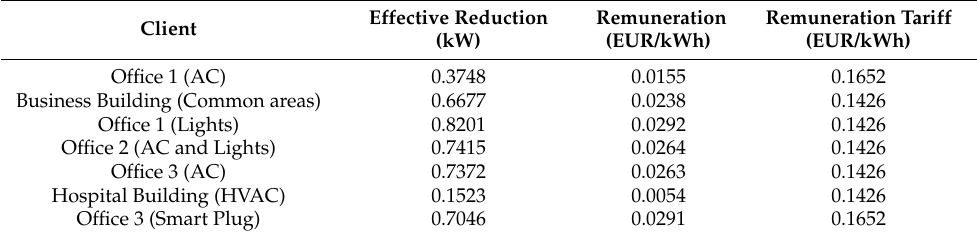
Table 3. Effective Reduction and